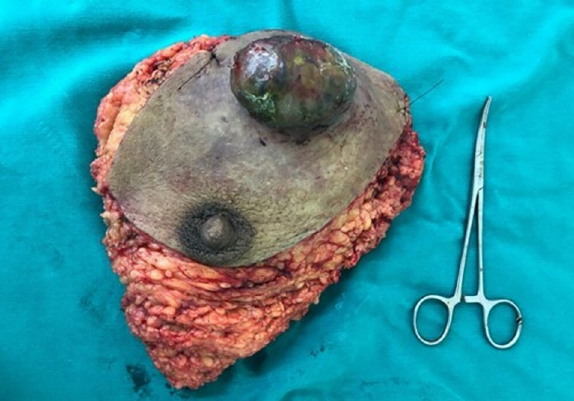
Figure 2. Surgically removed left breast showing a tumor simulating an abscess.